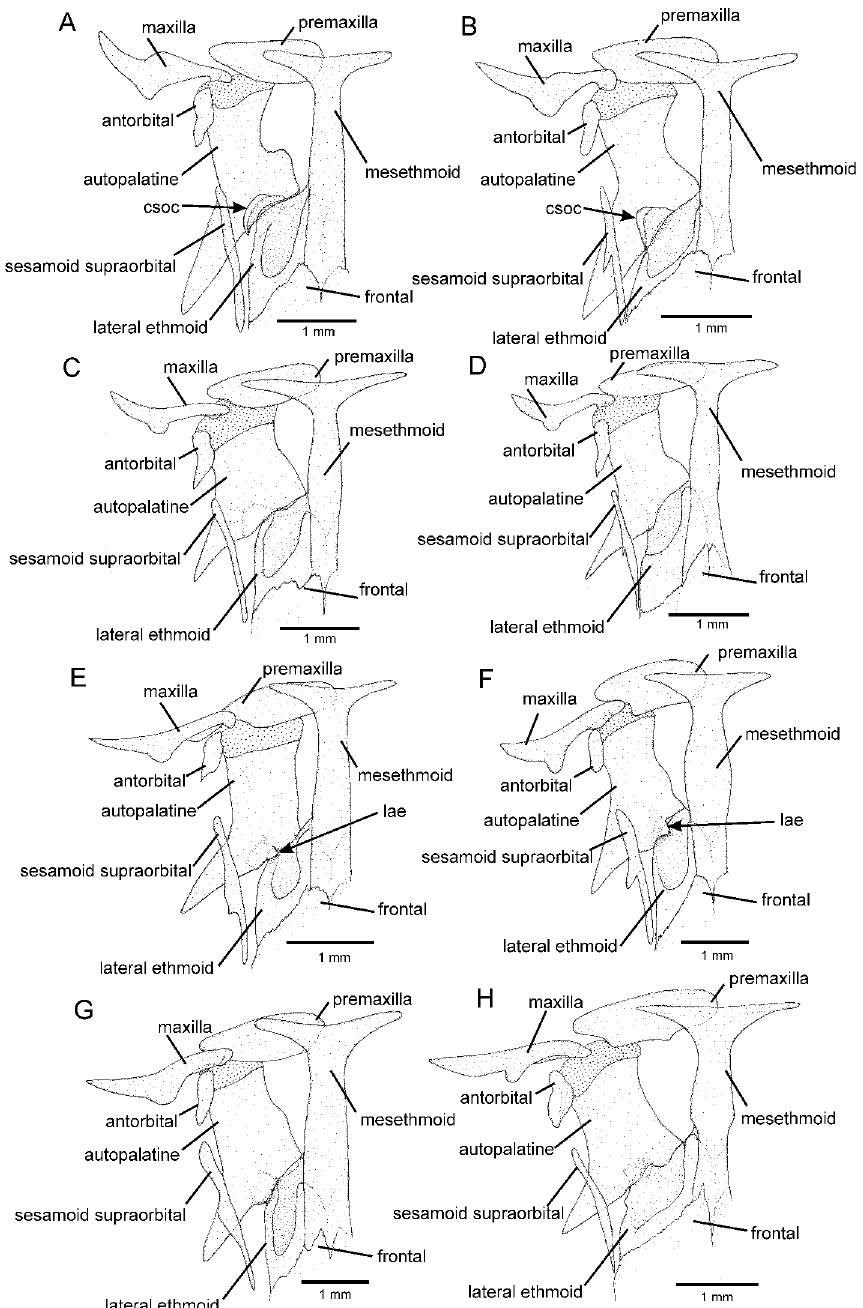
Figure 2. Mesethmoidal region, middle and left portions, dorsal view: ( A ) Trichomycterus auroguttatus ; ( B ) Trichomycterus goeldii ; ( C ) Trichomycterus puriventris ; ( D ) Trichomycterus saquarema Costa, Katz, Vilardo and Amorim, sp. nov.; ( E ) Trichomycterus travassosi ; ( F ) Trichomycterus altipombensis Costa, Katz, Vilardo and Mattos, sp. nov.; ( G ) Trichomycterus jacupiranga ; ( H ) Trichomycterus longibarbatus. Larger stippling represents cartilage. csoc, comma-shaped osseous core; lae, laminar articular expansion.